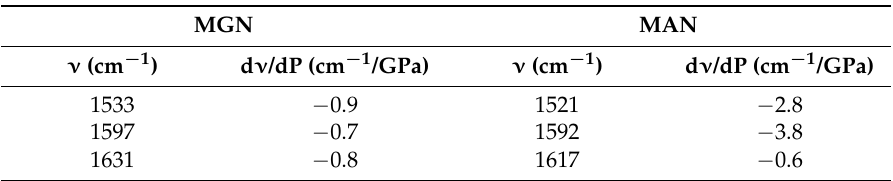
Table 1. The wavenumber at atmospheric pressure ν (cm − 1 ) of the deformation mode of NH 3+ unit and the variation of the wavenumber as a function of pressure (d ν